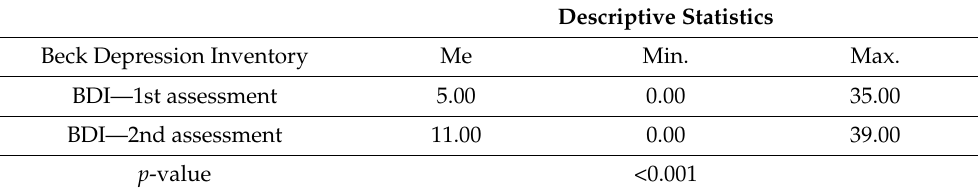
Table 8. Beck Depression Inventory.